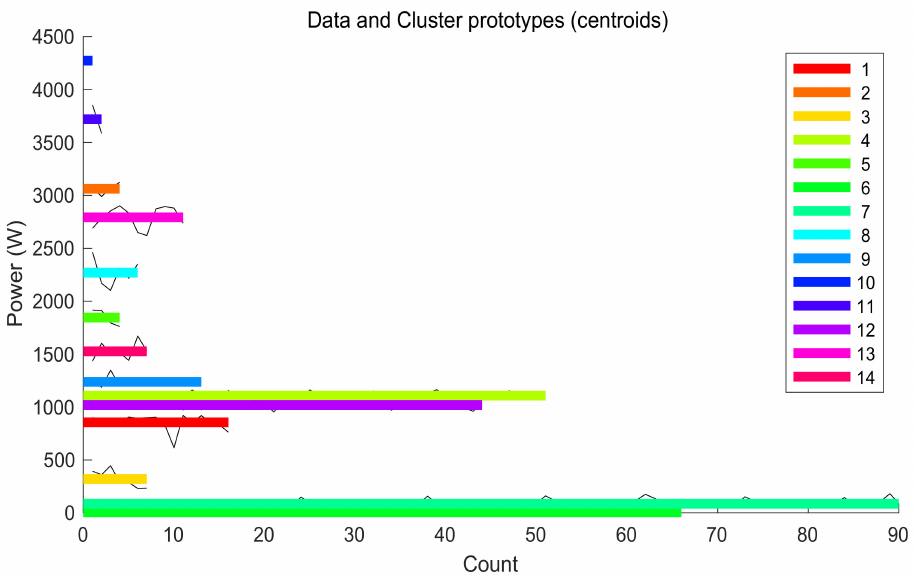
Figure 12. Results of the clustering of power levels of the global consumption signal.